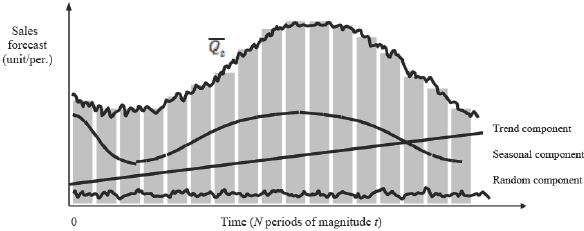
Figure 2: Evolution of expected average sales profiles within each period t over the time period of analysis.